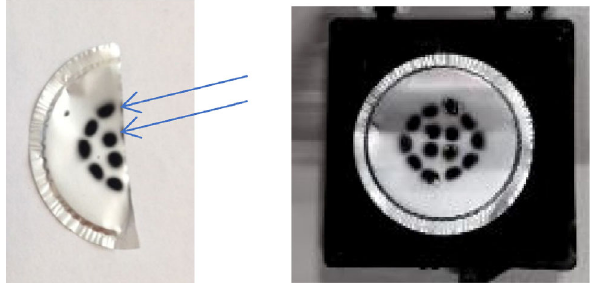
Fig. 4 Impactor Al collection plate (stage 12) with (black) spots of the collected particles. (a) Sampling procedure for EDXS analyzed spots C (center) and E (external), only half the disc is shown in the figure, (b) squared area of the XRF mapping (Fig.